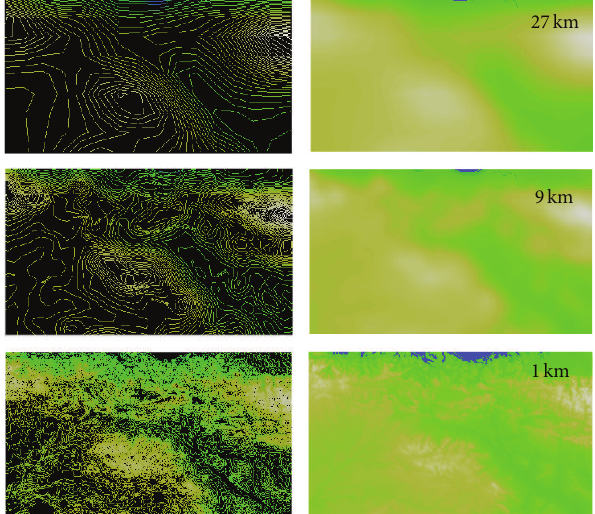
Figure 3: Example of different domains